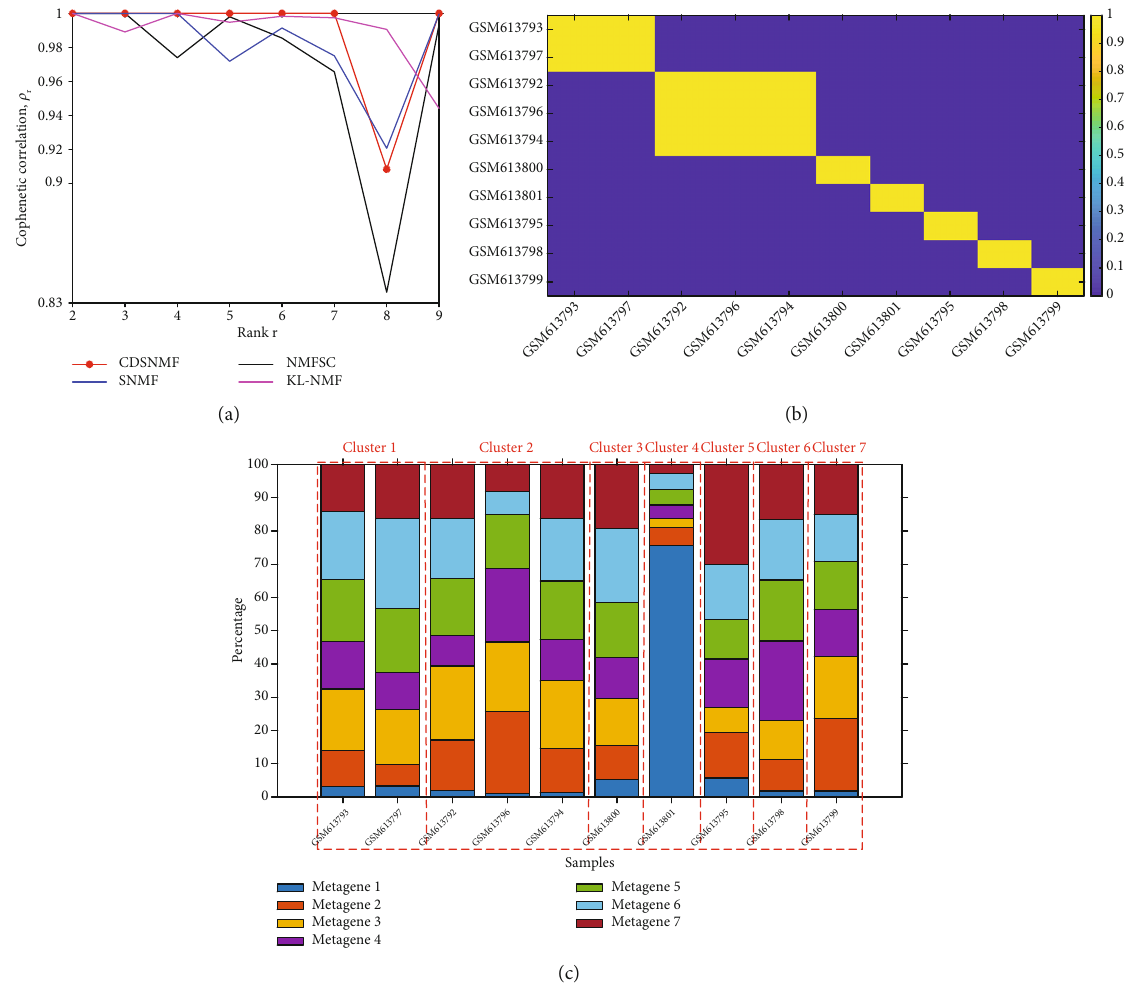
Figure 11: MM data: (a) cophenetic correlation coe ffi cient by varying r from 2 to 9. (b) Reordered consensus matrix for the optimal rank r = 7 using the winner algorithm CDSNMF. (c) Stacked bar plots of the encoding matrix V provided by CDSNMF for the optimal rank r = 7